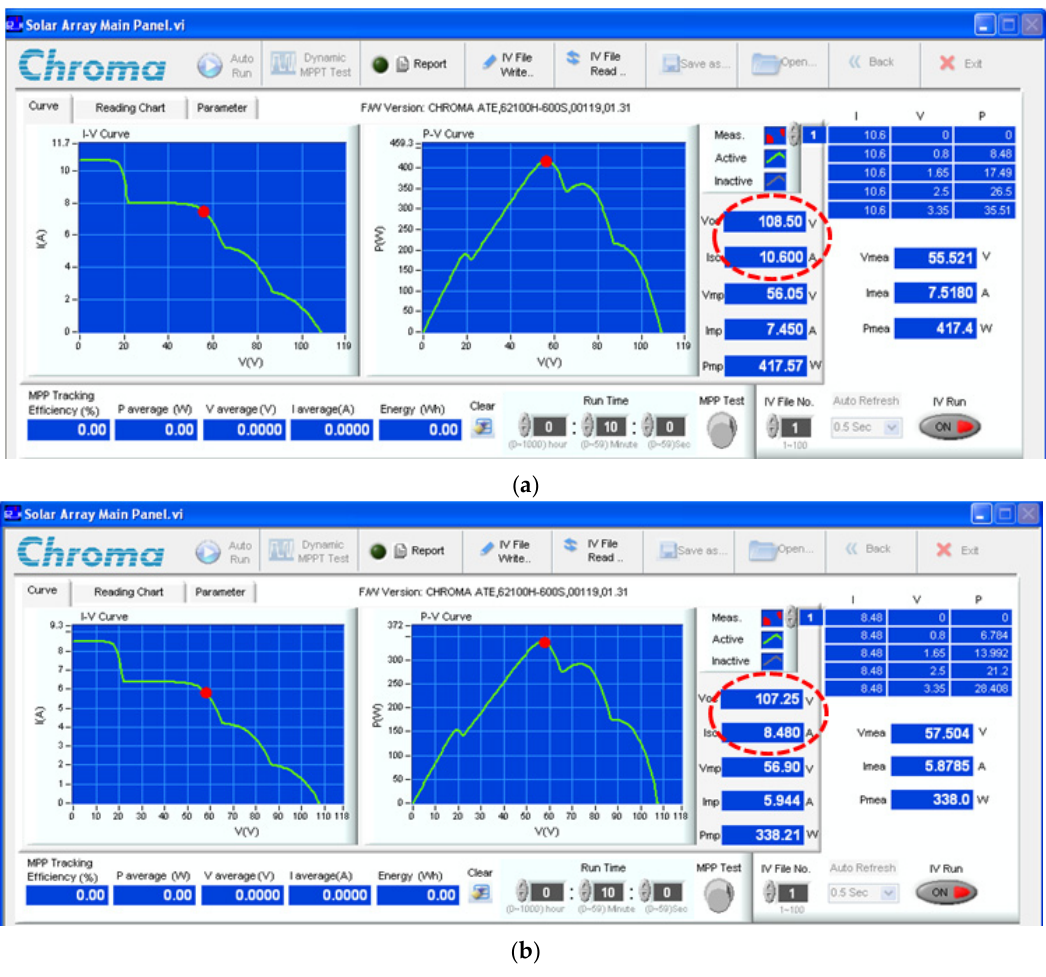
Figure 26. P ‐ V and I ‐ V curves under PSC for irradiations of ( a ) 1000 W/m 2 and ( b ) 800 W/m 2 .